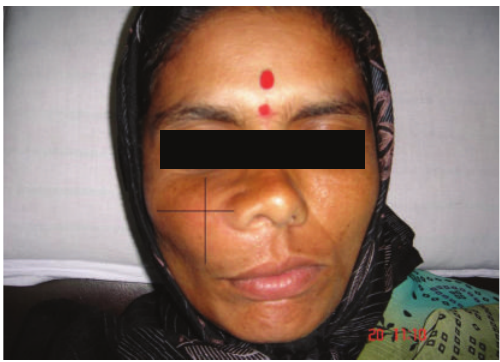
Figure 1: Clinical photographs showing appearance of swelling.